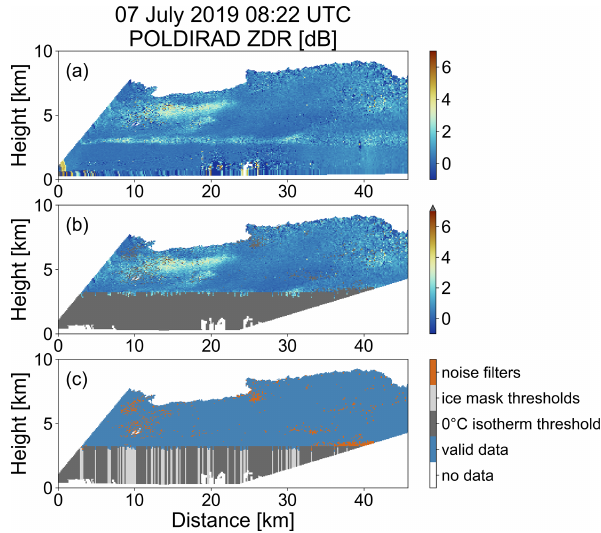
Figure B1. (a) Unfiltered POLDIRAD ZDR measurements from 7 July 2019 at 08:22UTC. (b) Noise-filtered and ice-masked values of POLDIRAD ZDR plotted with gray. (c) Different origin of filtered and masked values plotted with different